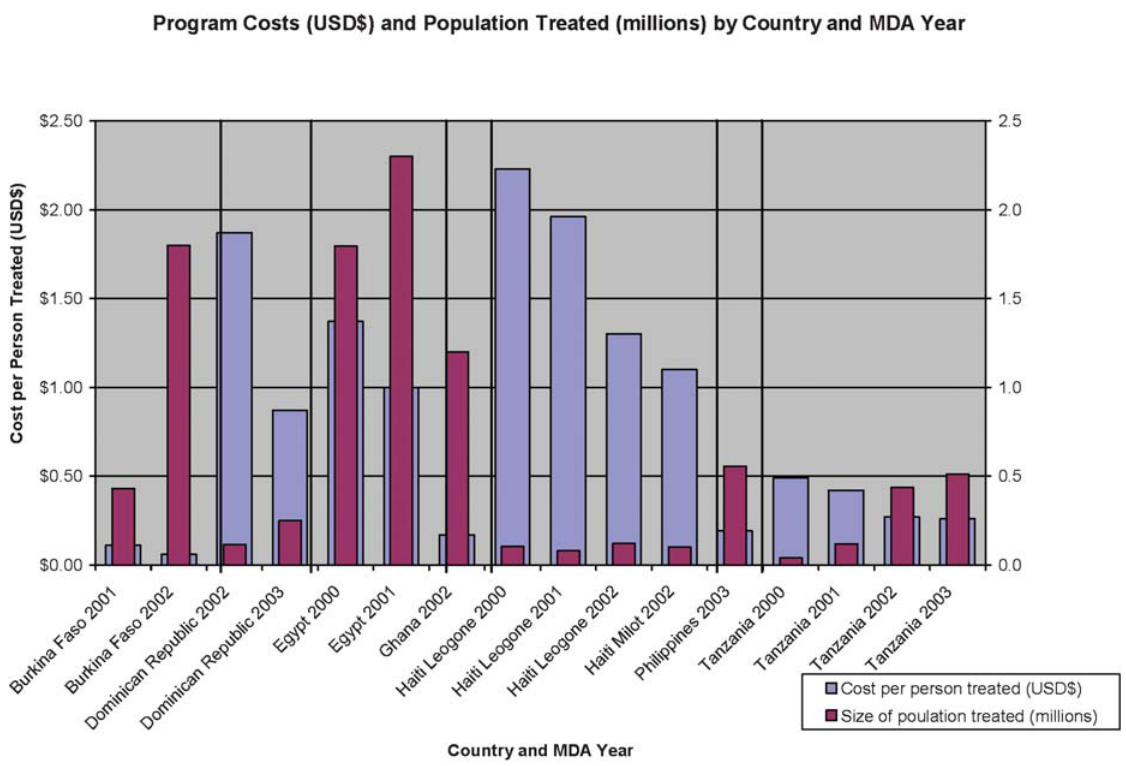
Figure 1. Financial Costs and Population Treated by Country and MDA Year.